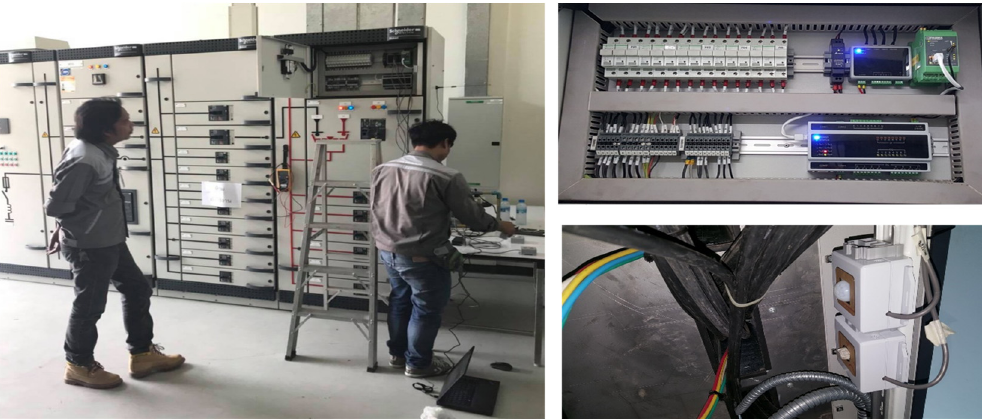
Figure 3. A display of an intranet sensors system installment in various electrical switchboard settings.